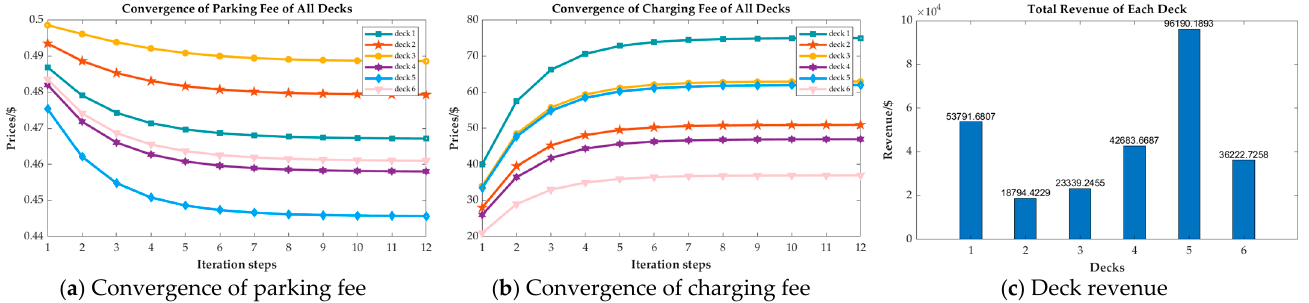
Figure 9. The electricity price, parking fee, and total revenue after reducing all LC customers in all decks and including them in Group LSC.